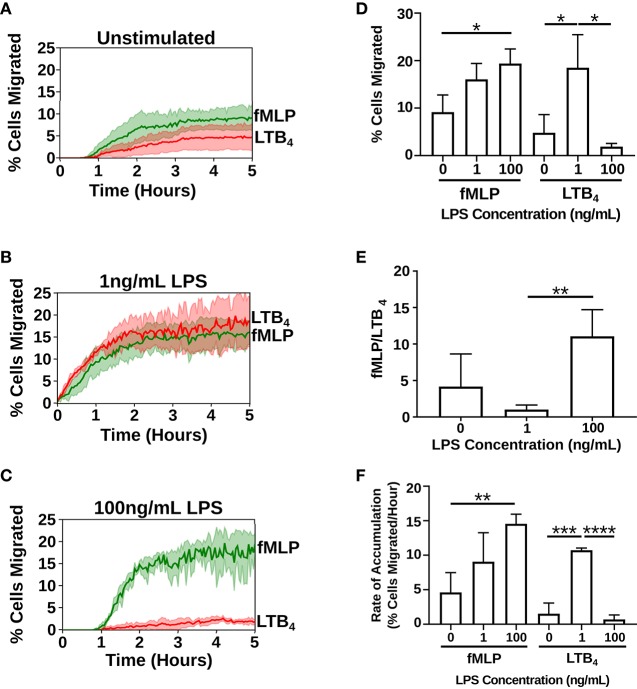
Priming with super-low dose LPS alters neutrophil migratory decision-making. Neutrophil (dHL-60 cells) migration counts in the fMLP chemoattractant reservoir (green) and LTB4 chemoattractant reservoir (red) over the duration of the experiment (5 h) (n = 3 separate experiments). (A) Unstimulated neutrophils preferentially migrate toward fMLP over LTB4. (B) Neutrophils stimulated with a super-low dose of LPS [1 ng/mL] preferentially migrate toward LTB4 over fMLP. (C) Neutrophils stimulated with a high dose of LPS [100 ng/mL] preferentially migrate toward fMLP over LTB4. (D) Percentage of cells migrating toward fMLP and LTB4 in the different treatment groups. dHL-60 cells show a significant increase in migration toward fMLP when stimulated with a high-dose of LPS. dHL-60 cells show a significant increase in migration toward LTB4 when stimulated with a super-low dose of LPS compared to the unstimulated cells. dHL-60 cells showed a significant decrease in migration toward LTB4 between the super-low dose and high-dose stimulation with LPS. (E) Ratio of cells migrating toward fMLP over LTB4. Neutrophils significantly migrate toward fMLP over LTB4 when stimulated with a high-dose of LPS vs. a super-low dose of LPS. (F) Calculated slope from the hour in which there was the highest accumulation of dHL-60 cells in the chemoattractant reservoirs. Data expressed as means and standard deviations. *p < 0.5, **p < 0.005, ***p < 0.0005, ****p < 0.0001.